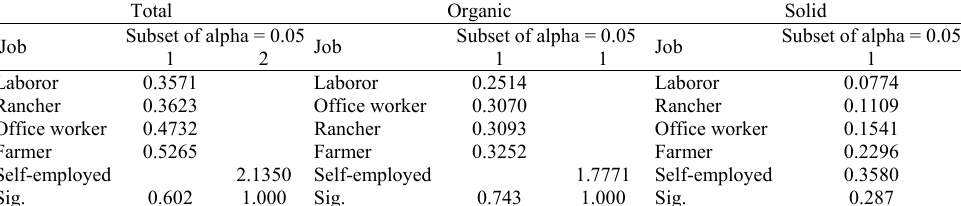
Table 7: Result of Duncan’s multiple range test for comparison between the types of occupation